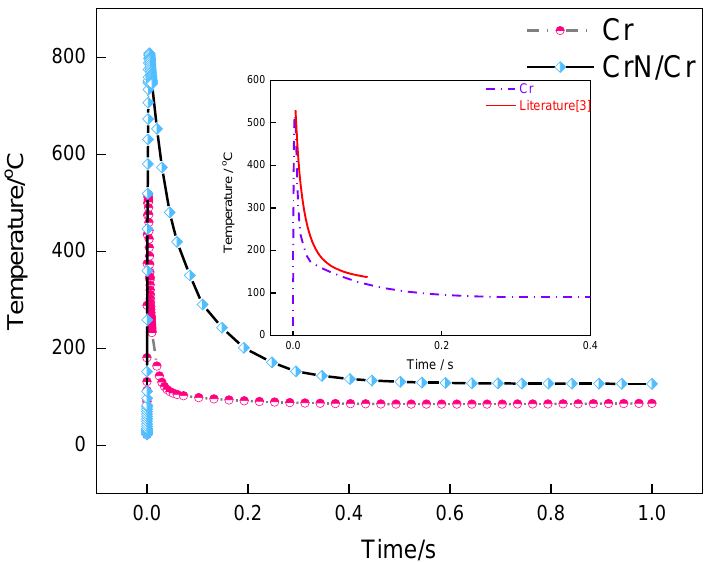
Figure 4. Variation curves of maximum temperature in bore of Cr coating barrel and CrN/Cr composite coating barrel with gun firing time.